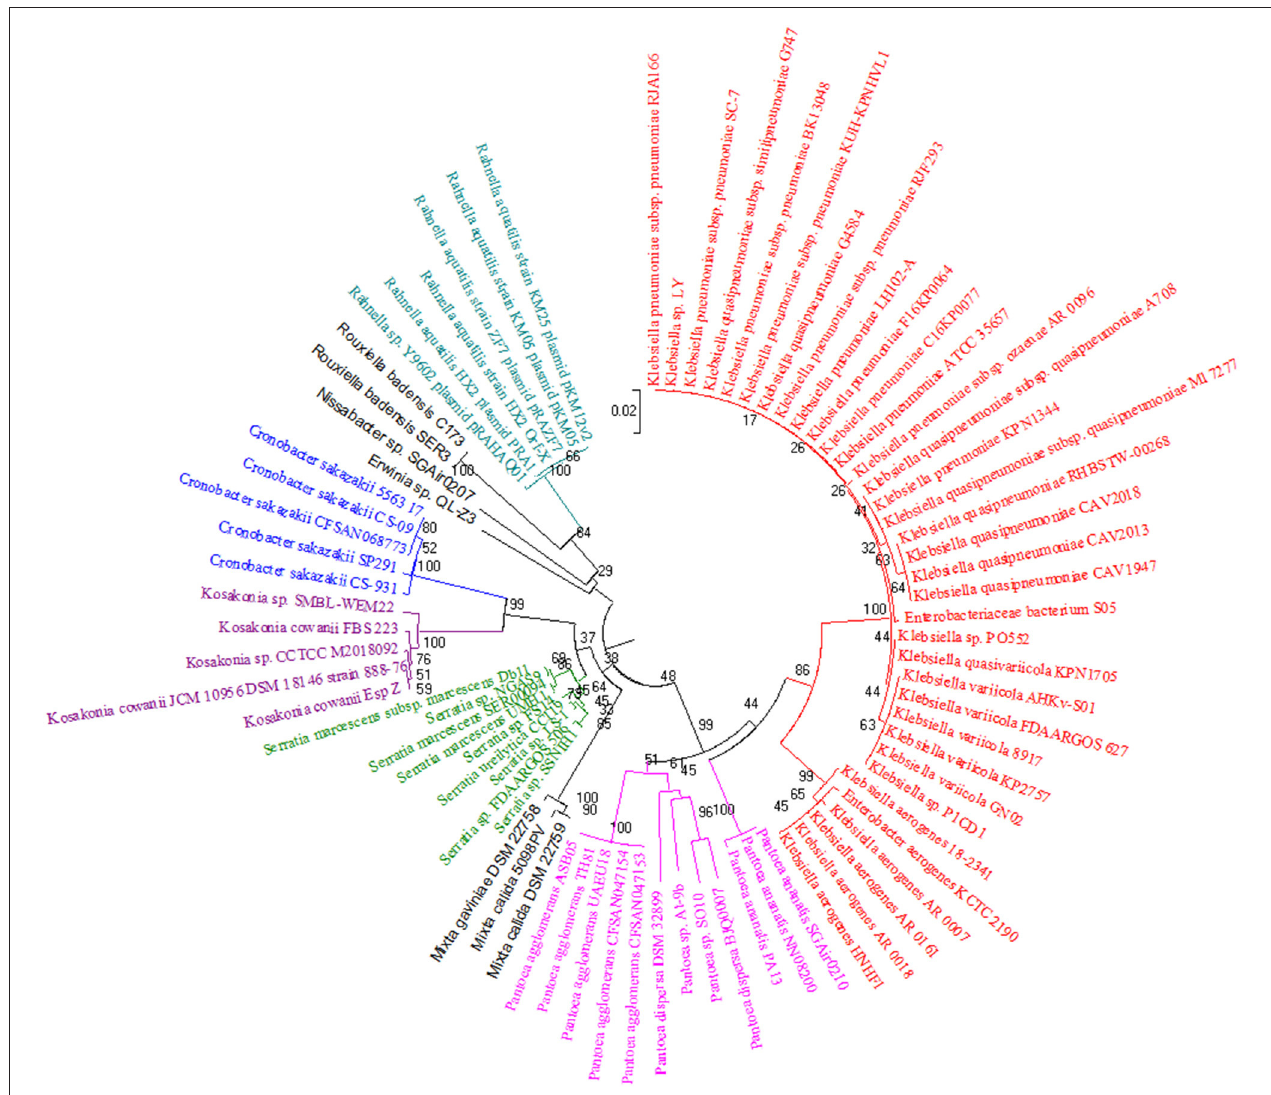
FIGURE 1 | Phylogenetic tree showing the relationship between the diverse Gammaproteobacterial groups considered in this study based on homologs of PQQ biosynthesis pathway-associated pqqC gene sequences. Amino acid sequences of pqqC genes from S. marcescens (DQ868536.1) and their homologous sequences from various Gammaproteobacterial species, including Klebsiella , Enterobacter , Pantoea , Nissabacte r, Erwinia , Kosakonia , Rahnella , Mixta , Cronobacter , Rouxiella, and Serratia , were aligned with Clustal W algorithm, and the unrooted phylogenetic tree was constructed by the Neighbor-joining method based on the p-distance using MEGA6.06 software (http://www.megasoftware.net/, Kumar et al., 2008). The bootstrap consensus tree inferred from 1,000 replicates is taken to represent the evolutionary relationship of the taxa analyzed (Felsenstein, 1985). The number in each node indicates the confidence value of that branch after bootstrapping the phylogenetic tree. A uniform rate was used to model evolutionary rate differences among sites. Complete deletion of gaps/missing data was used. Phylogenetic trees generated from pqqA , pqqB , pqqD , and pqqE are shown in Supplementary Figures 1–4